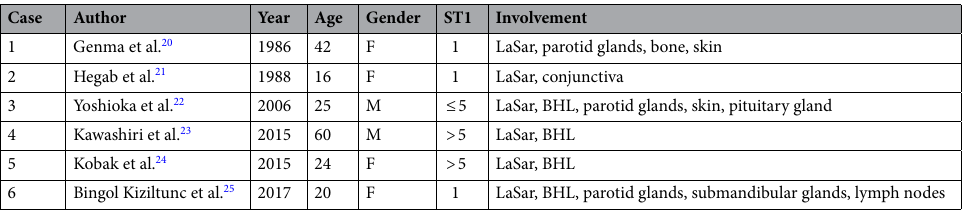
Table 3. Cases of sarcoidosis with lacrimal gland involvement. ST1 the Schirmer 1 test, LaSar Lacrimal sarcoidosis, BHL bilateral hilar